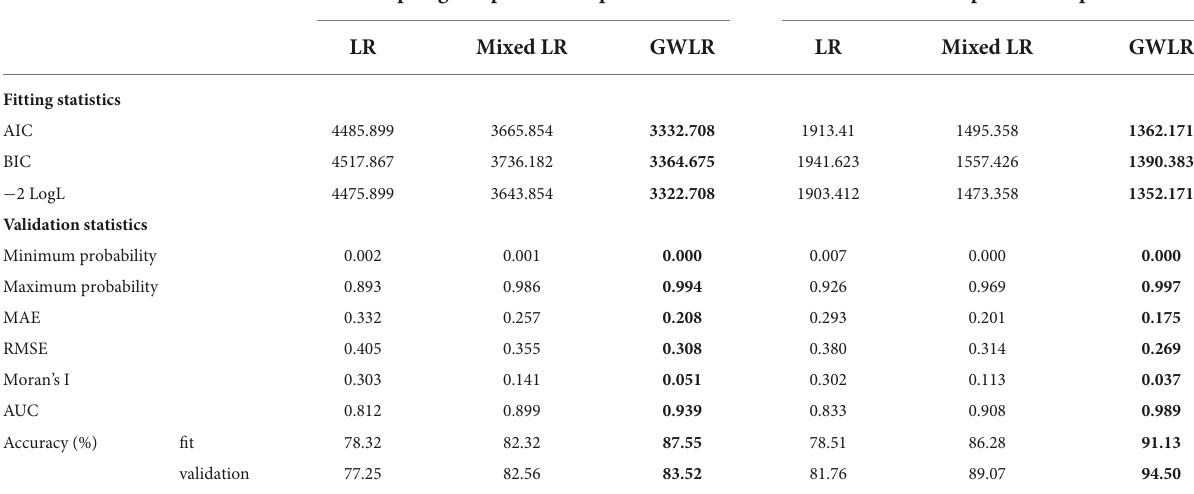
TABLE 5 Model fitting and validation for two fire prevention periods.